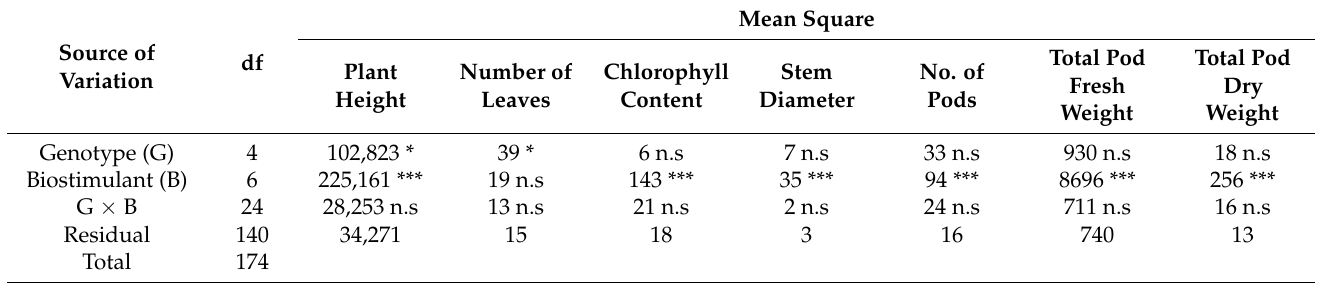
Table 1. Analysis of variance for the effect of biostimulant and genotype on Abelmoschus esculentus growth and yield. df = Degree of freedom.